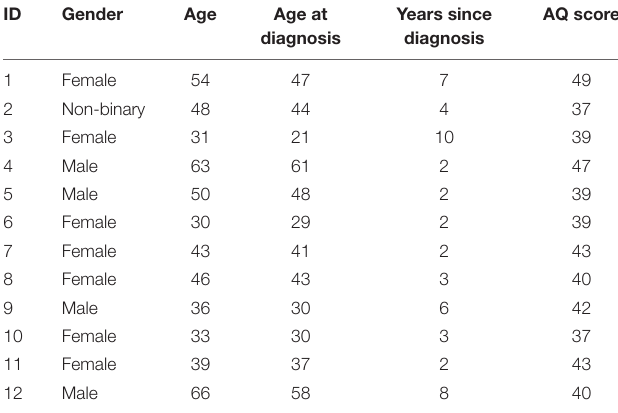
TABLE 1 | Participant demographic